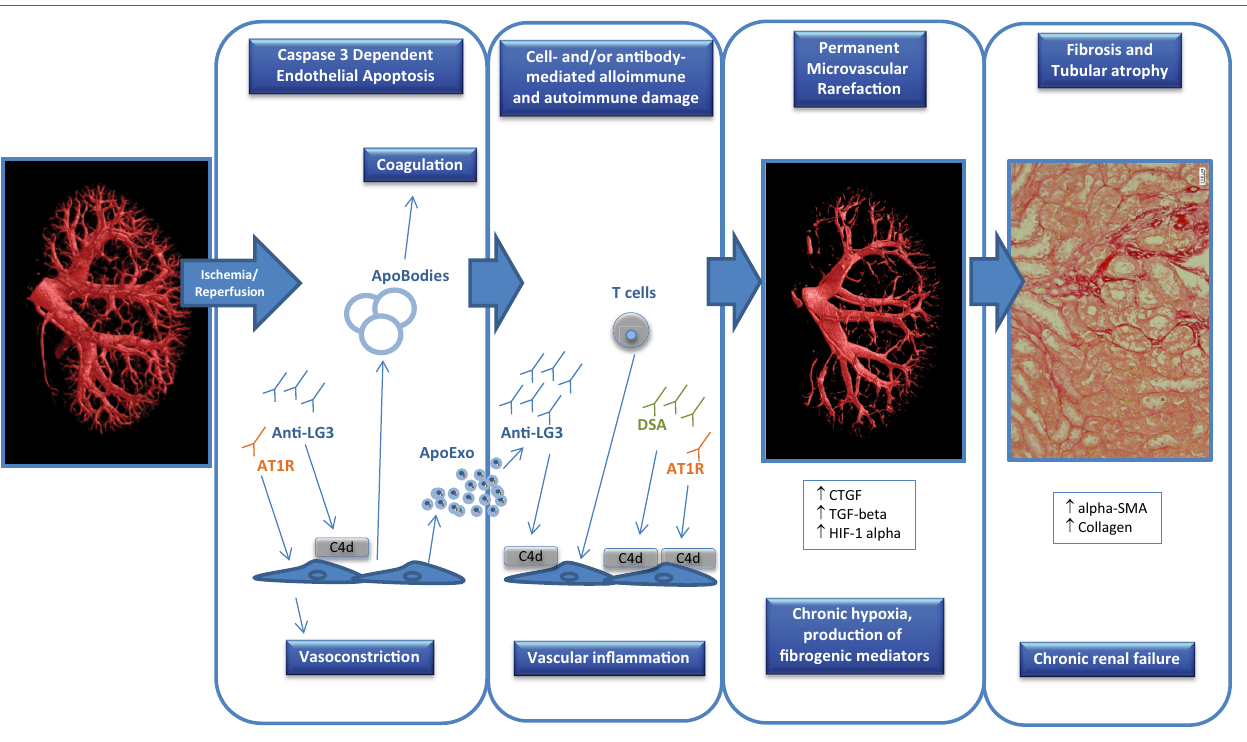
FiGURe 1 | Factors contributing to endothelial dysfunction in transplantation. Ischemia-reperfusion injury that occurs at the time of transplantation can trigger endothelial apoptosis through caspase-3 activation which can in turn release apoptotic bodies with procoagulant activity. In addition, apoptotic endothelial cells also release apoptotic exosome-like vesicles that favor the recruitment of inflammatory cells (e.g., T cells) and the production of autoantibodies such as anti-perlecan/ LG3 antibodies (anti-LG3). The synergistic interactions between cellular alloimmunity and autoimmunity, donor-specific antibodies (DSA), and autoantibodies [anti-LG3, anti-angiotensin II type 1 receptors (AT1R)] amplify microvascular damage, through complement-dependent (C4d deposition) or -independent pathways, which leads to permanent peritubular capillary rarefaction. Loss of peritubular capillaries favors chronic hypoxia, leading to overexpression of hypoxia inducible factor 1 α (HIF-1 α ), favoring transcription of fibrogenic genes such as transforming growth factor β (TGF- β ) and connective tissue growth factor (CTGF). It also favors accumulation of collagen, α -smooth muscle actin ( α -SMA) positive myofibroblasts and of fibrogenic mediators. These phenomena eventually lead to progressive interstitial fibrosis/tubular atrophy and renal graft